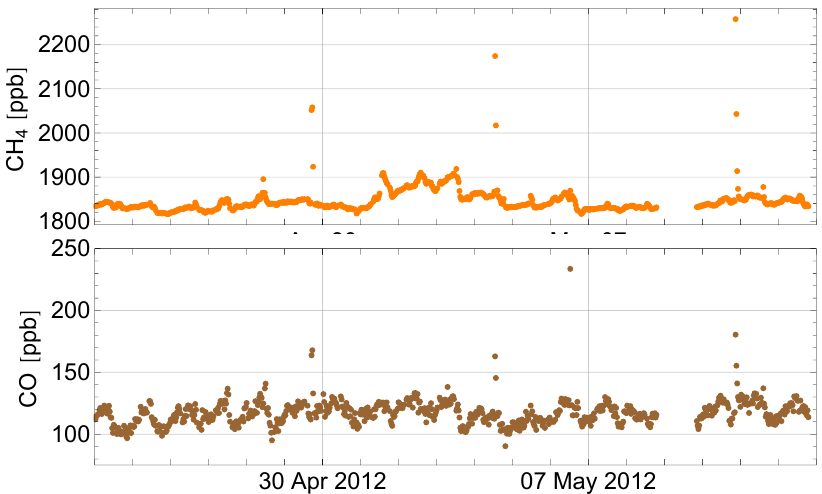
Figure 18. Examples of sporadic concurrent increases in CH 4 and CO recorded at the lowermost (4m) inlet in 2012.